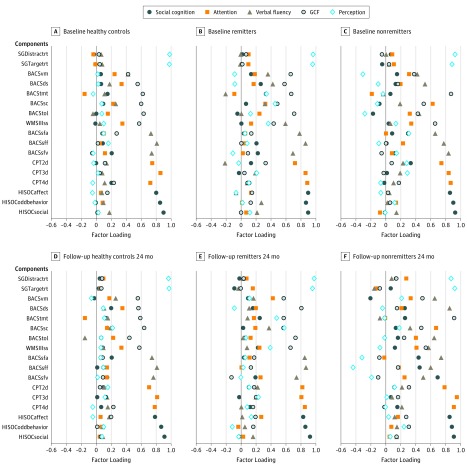
Component Loading Plots for Baseline and 24-Month Follow-up by Healthy Controls,
Remitters, and NonremittersA-C, Component loading plots for baseline. D-F, Component loading plots for 24-month
follow-up. BACS indicates Brief Assessment of Cognition in Schizophrenia (ds, digit
sequencing; sc, symbol coding; sfa, verbal fluency—animals; sff, verbal
fluency—fruits; sfv, verbal fluency—vegetables; tmt, token motor task;
tol, Tower of London; vf, verbal fluency; vm, verbal memory); Continuous Performance
Task: 2d, 2Digit, 3d, 3Digit, 4d, 4 Digit subtasks; GCF, general cognitive function;
HISOC, High-Risk Social Challenge; SG, Snakes in the Grass (Distractrt, distractor
reaction time; Targetrt, target reaction time); WMSIIIss, Wechsler Memory Scale-III
Spatial Span.